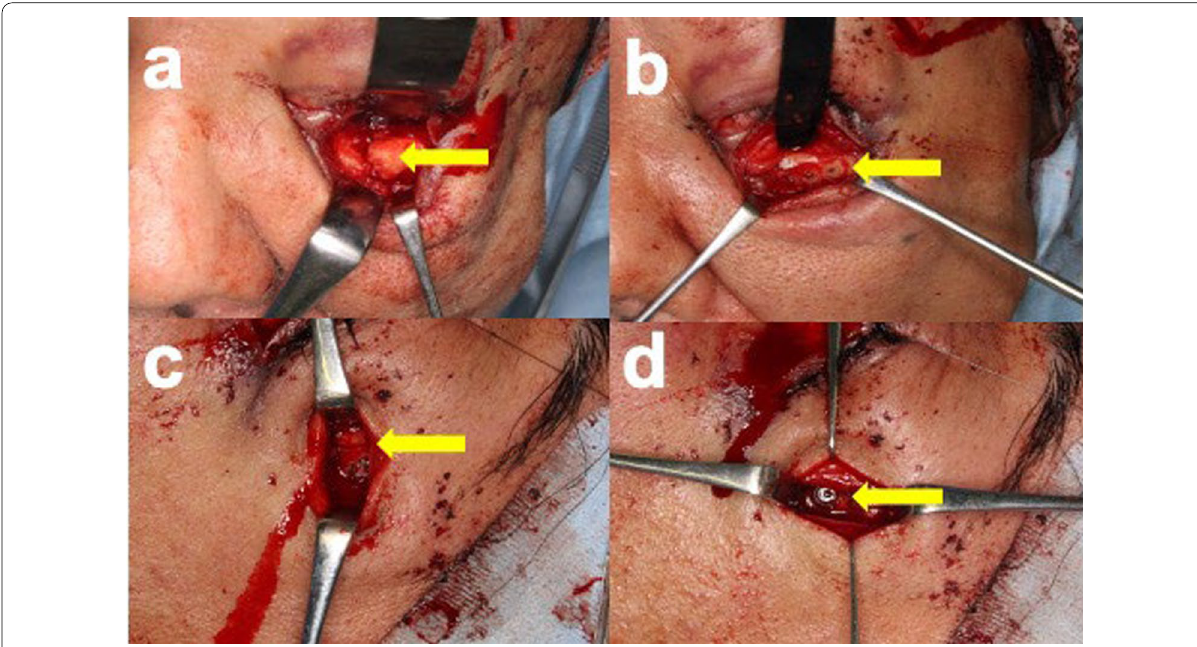
Fig. 3 a Fracture at the infraorbital margin. b After plating at the infraorbital margin using a straight 4-hole, a 1.0 mm plate and four 5 mm pins were inserted. c Fracture at the frontal zygomatic suture. d After plating at the frontal zygomatic suture using a straight 4-hole, a 1.0 mm plate and four 5 mm pins were